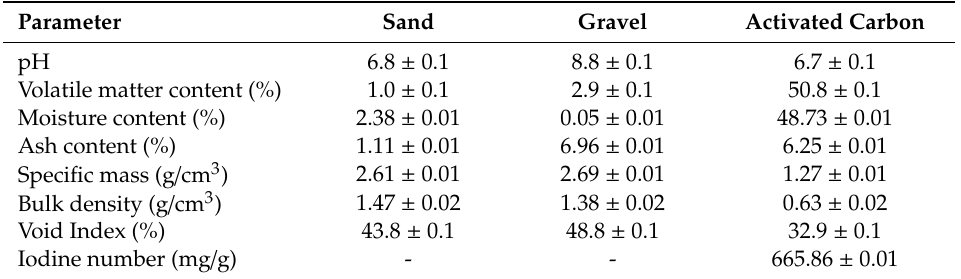
Table 2. Average values and standard deviation of the parameters used for the physicochemical characterization of the sand, gravel, and activated carbon.